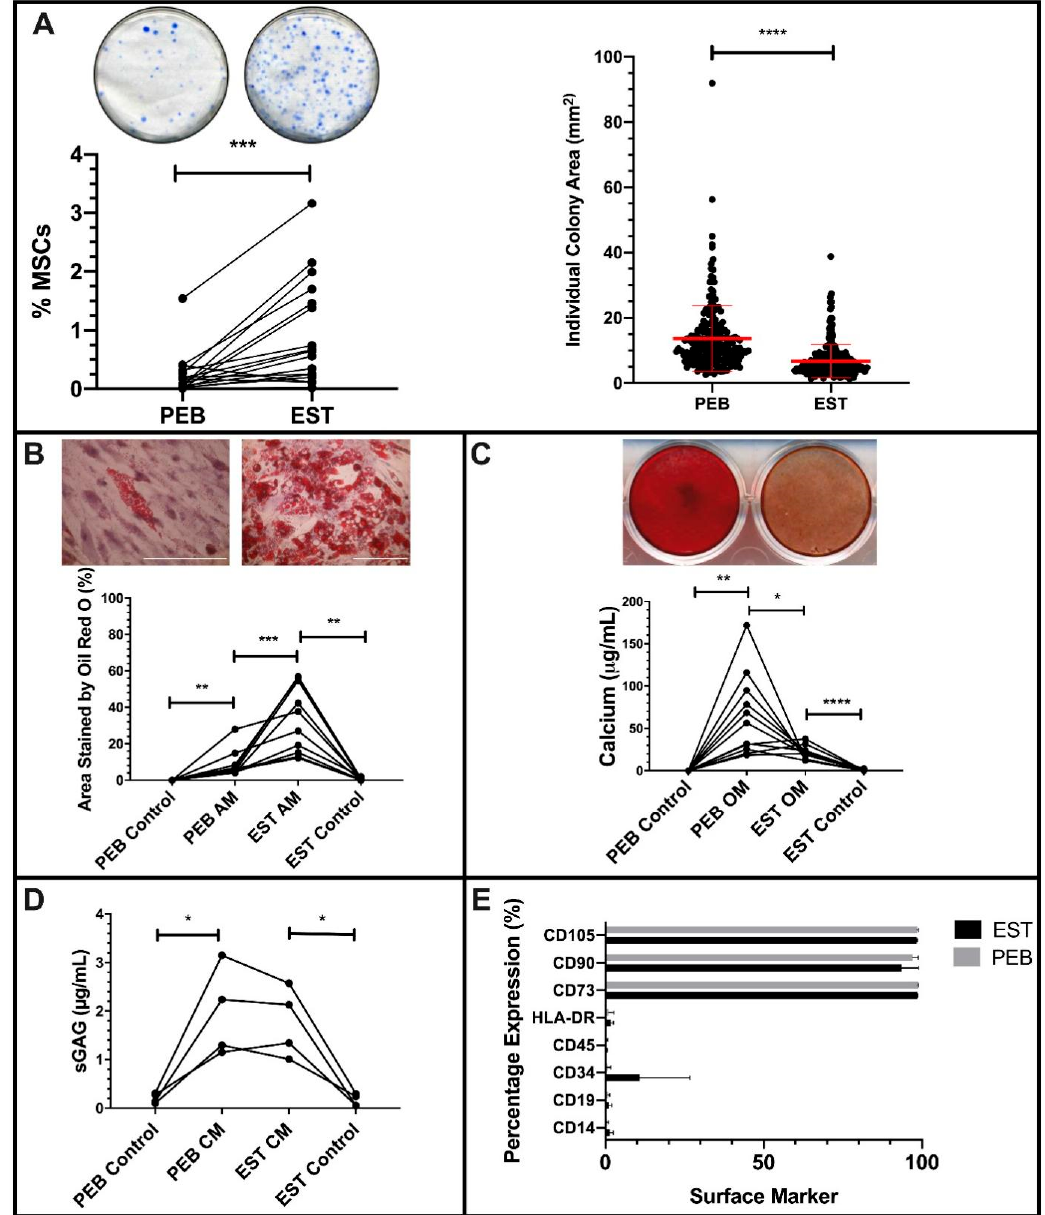
Figure 1. Characterization of peri-entheseal bone (PEB) and entheseal soft tissue (EST) mesenchymal stem cells (MSCs). Colony Forming Unit Fibroblast (CFU-F) (( A ), Paired t -Test, n = 16) of PEB and EST MSCs shows a significantly higher CFU-F capacity of EST compared to PEB. Individual colonies are also significantly larger in PEB MSCs compared to EST MSCs (Mann–Whitney U Test). ESTs produce significantly more adipocytes than matched PEB MSCs after Oil Red O staining (( B ), repeated measures (RM) One-Way ANOVA with Tukey Post-Hoc Test, n = 10). Alizarin red staining (( C ), RM One-Way ANOVA with Tukey Post-Hoc Test, n = 11) of osteogenically differentiated PEB and EST MSCs show that matched PEB MSCs produce significantly more calcium than matched EST MSCs. There was no significant difference in the chondrogenic differentiation between PEB and EST MSCs (( D ), RM One-Way ANOVA with Tukey Post-Hoc Test, n = 4). Both culture expanded PEB and EST MSCs ( n = 3) were positive for MSC lineage markers and were negative for the hematopoietic lineage markers ( E ). Error bars = mean ± SD * = p < 0.05, ** = p < 0.01, *** = p < 0.001 and **** = p < 0.0001. Scale bar = 100 µ m. AM = adipogenic media, CM = chondrogenic media, and OM = osteogenic